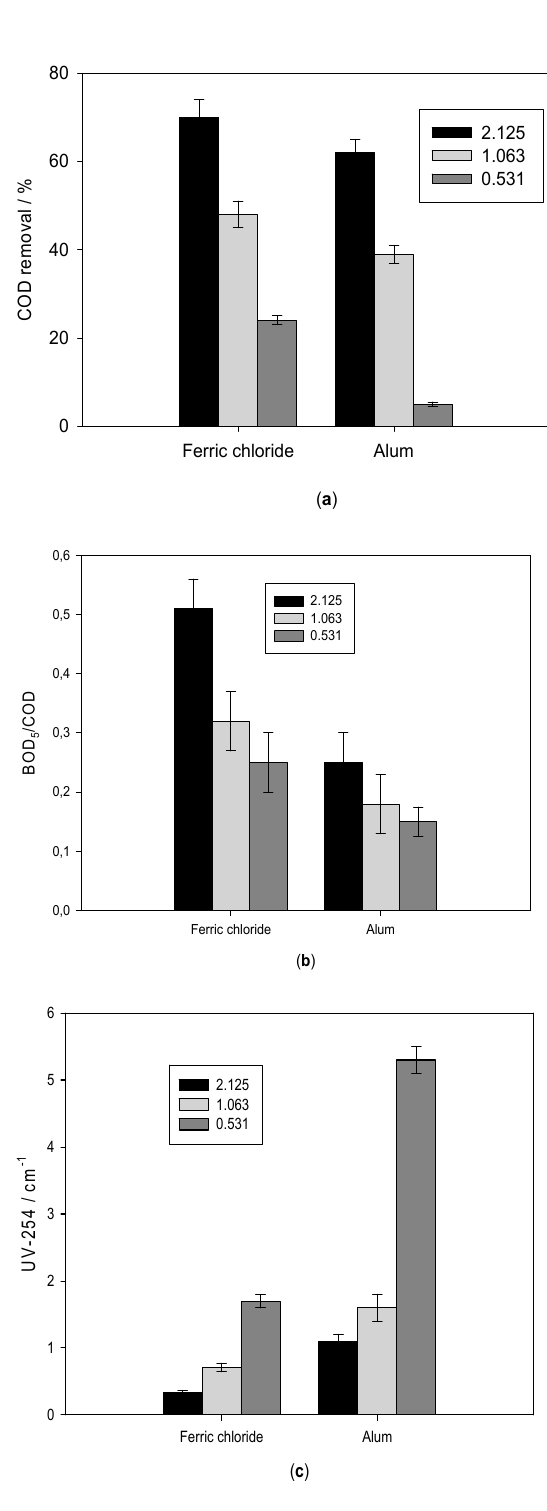
Figure 3. Differences between FeCl 3 followed by homogeneous photo-Fenton and alum followed by ZVI heterogeneous photo-Fenton: ( a ) percentage of COD removal; ( b ) biodegradability enhancement through BOD 5 /COD; ( c ) UV-254 absorbance.